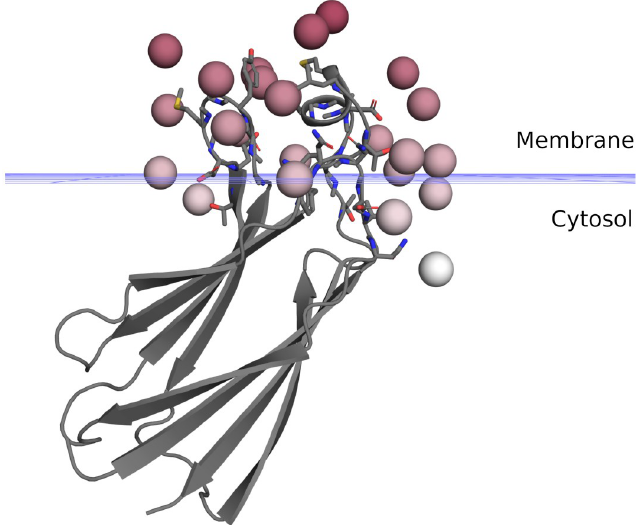
Fig 6. Membrane docking of the cPLA2 C2 domain (PDBID 1BCI). The cPLA2 C2 domain is shown as a gray cartoon. Spin centroids are shown as red spheres with their color saturation mapped to the experimental depth. Native side chains of spin labeled sites are shown as sticks. The blue grid indicates the phosphate plane of the